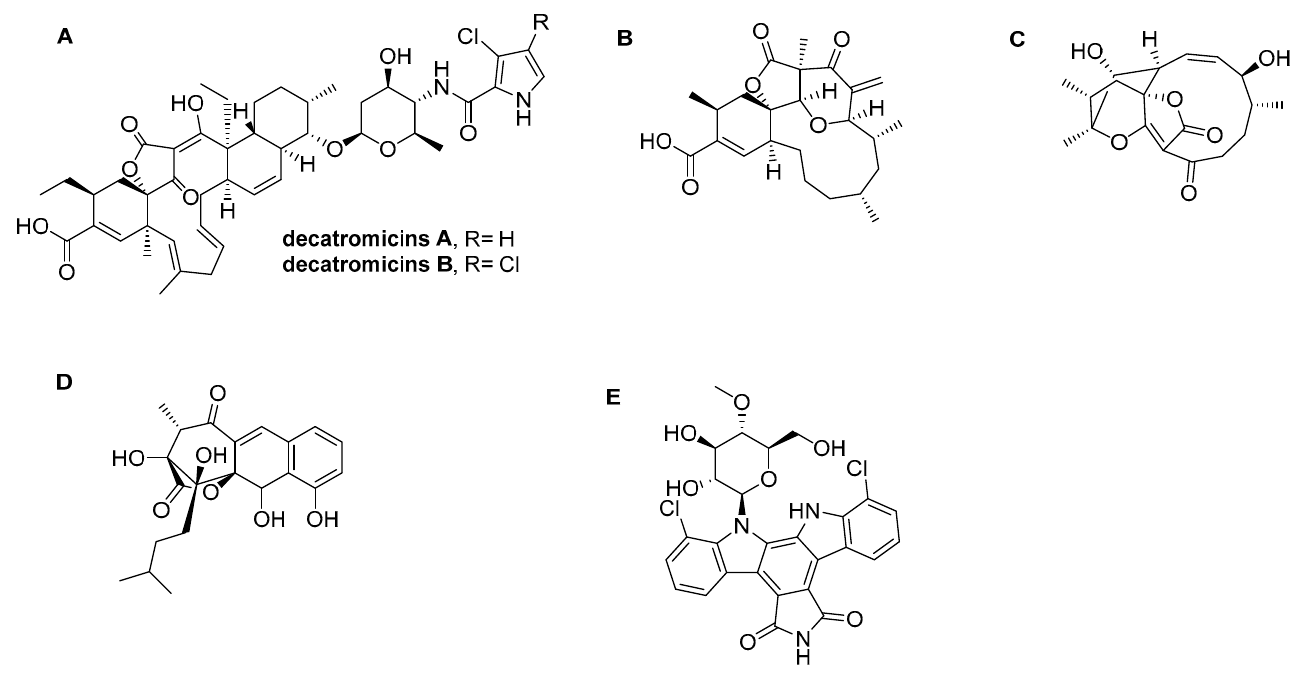
Figure 2. Chemical structures of compounds targeting the fsr QS system of E. faecalis . ( A ) Decatromicin A and B, ( B ) Okilactomycin, ( C ) Abyssomicin I, ( D ) Rishirilide A, ( E ) Rebeccamycin.